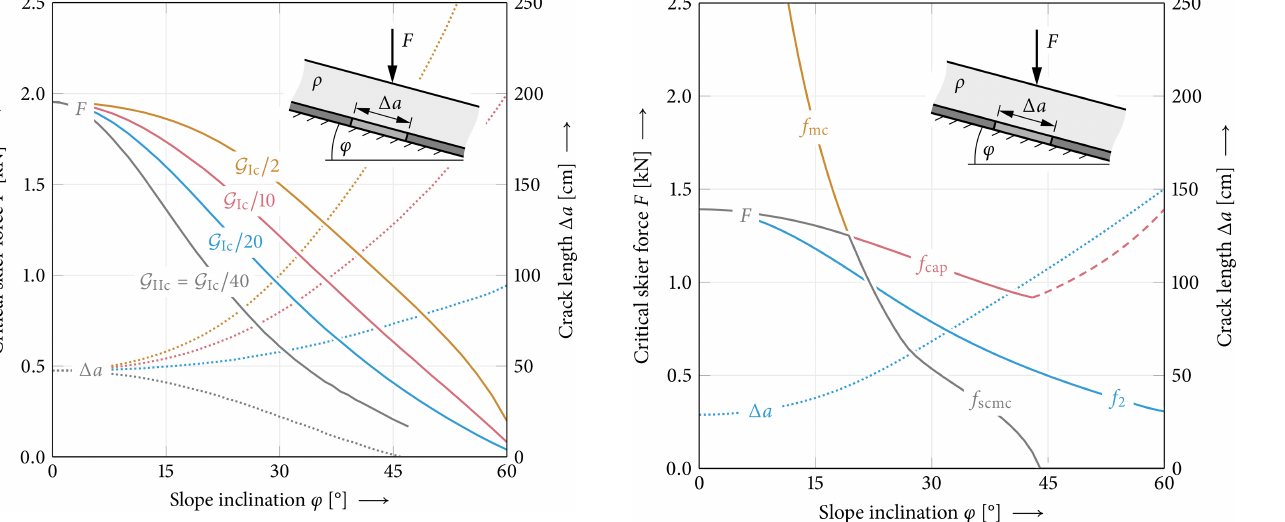
Figure 9. Comparison of mixed-mode stress criteria for a defect- free snowpack with slab thickness h = 20cm. The quadratic in- teraction criterion f 2 , the smooth capped Mohr–Coulomb criterion f scmc , and the constituents of the Mohr–Coulomb criterion f mc and f cap are